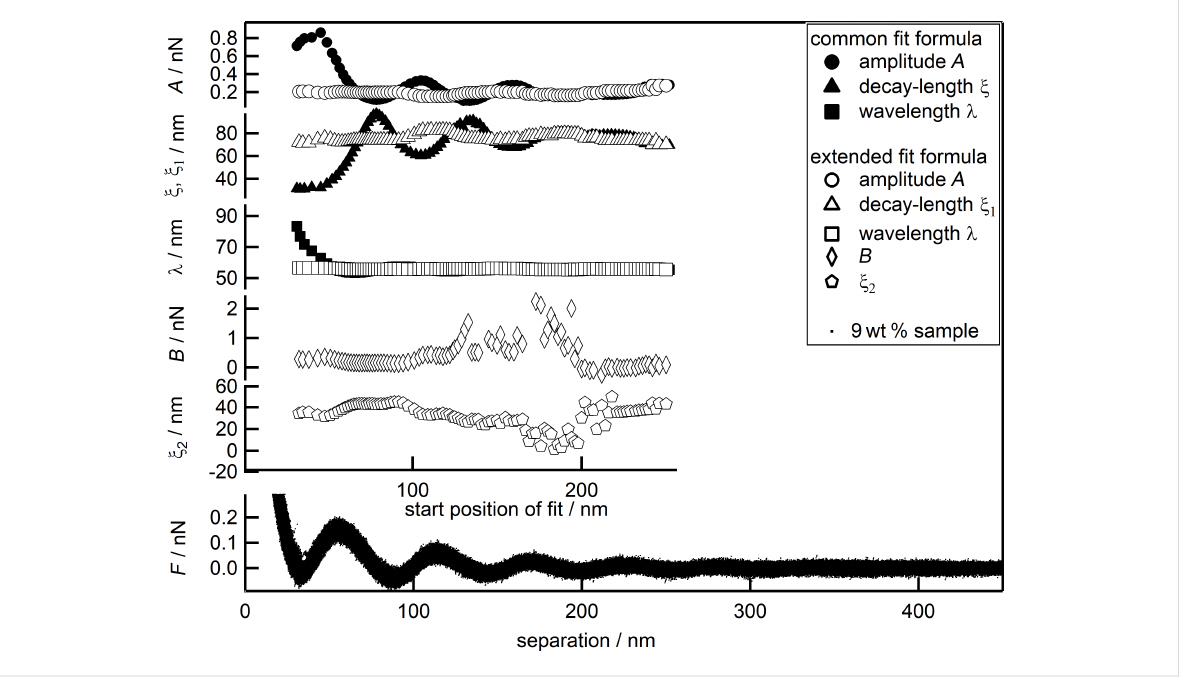
special concern and will be discussed below, they are named individually. The decay length derived from the common equa- tion will henceforth be named as ξ , while the decay length from the extended equation will be named as ξ 1 for the first term and ξ 2 for the newly introduced second